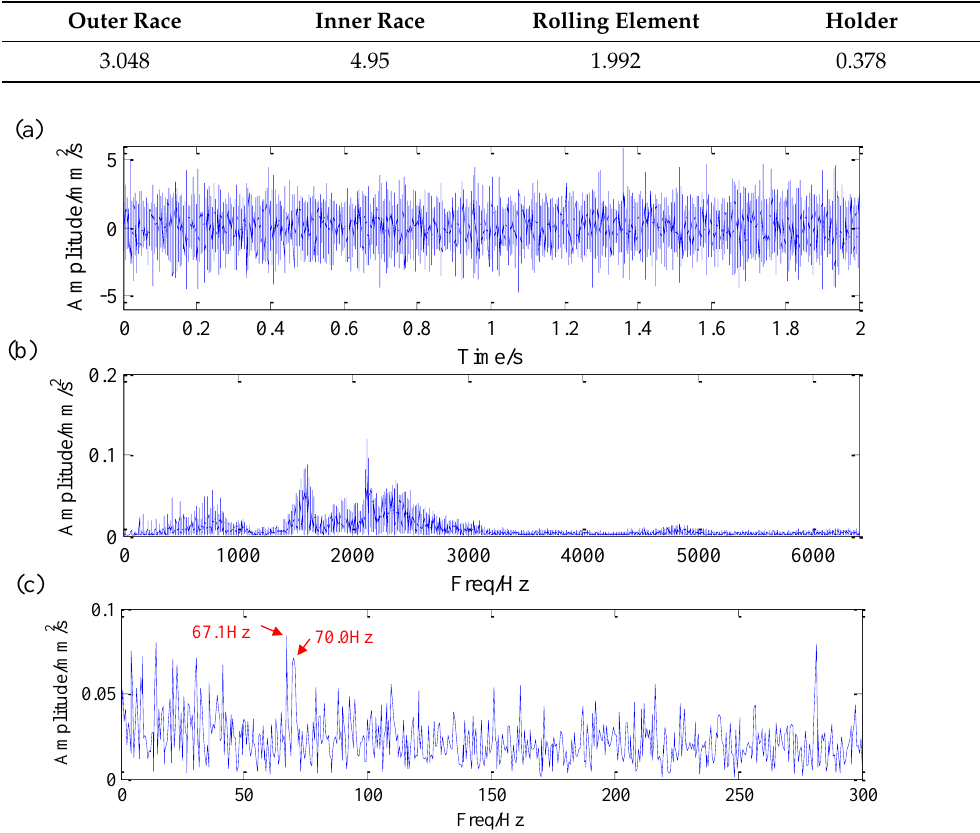
Figure 13. Fault bearing vibration signal: ( a ) waveform and ( b ) spectrum and ( c ) envelope spec- trum.